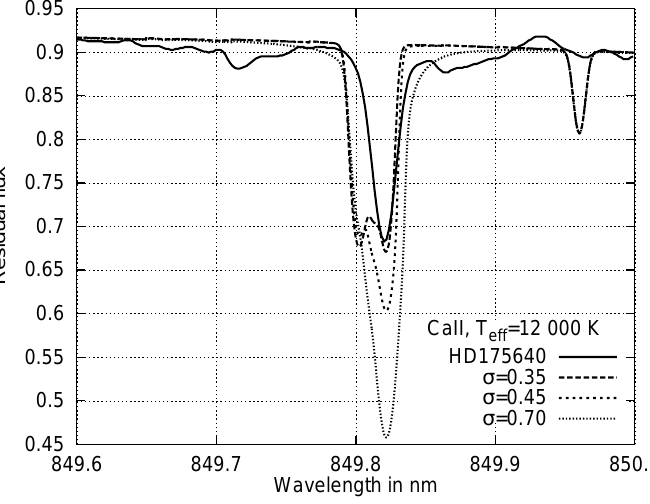
Fig. 8. The same as in Fig. 7, but for the 849.82 nm